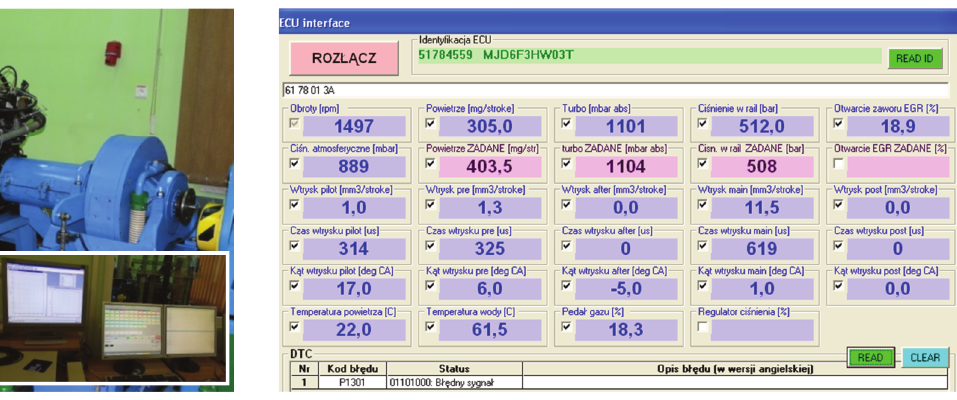
Fig. 6. The engine mounted on the dynamometer stand and the test bench management system monitors [7]